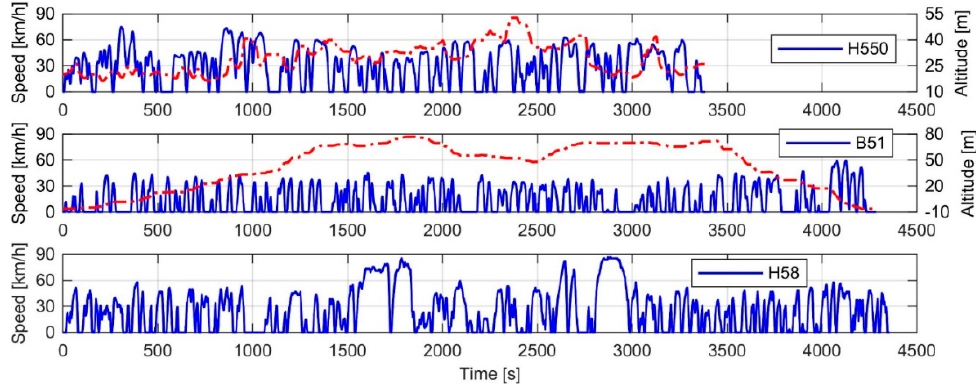
Figure A3. City bus driving cycles with a maximum duration of 4500 s.